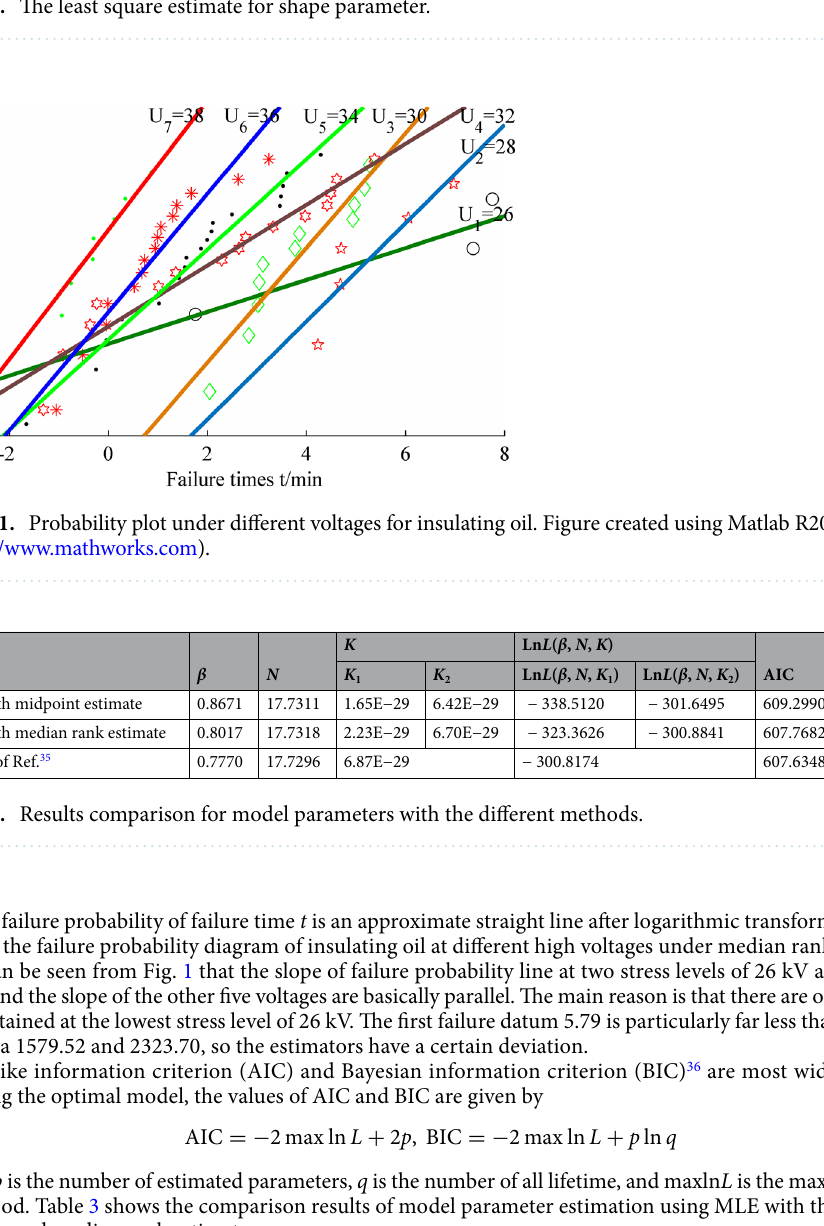
Table 2. The least square estimate for shape parameter.